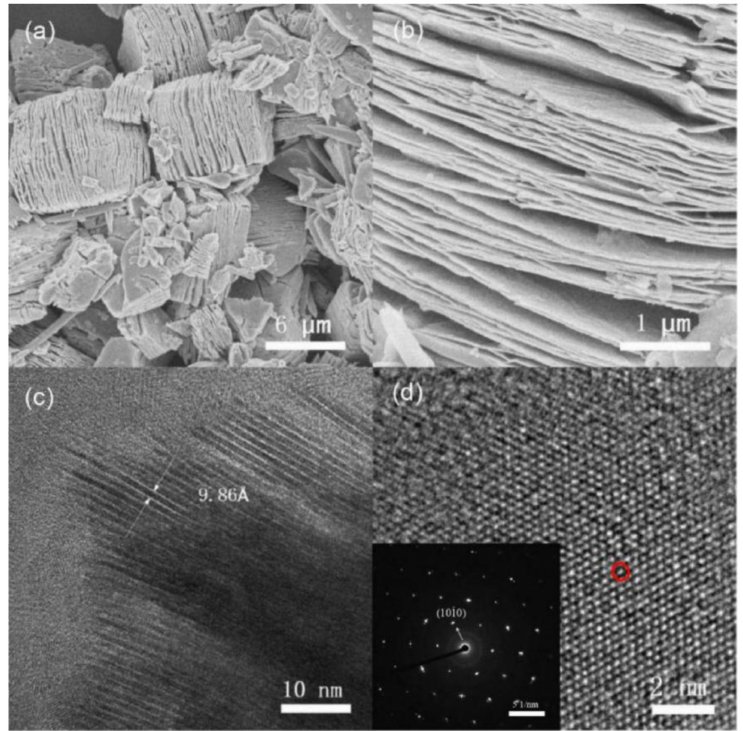
Figure 2. ( a , b ) SEM images of layered Ti 3 C 2 after HF treatment. ( c ) The interlayer distance of layered Ti 3 C 2 sheets was determined via TEM. ( d ) HR-TEM image of Ti 3 C 2 and inset showing the corresponding SAED